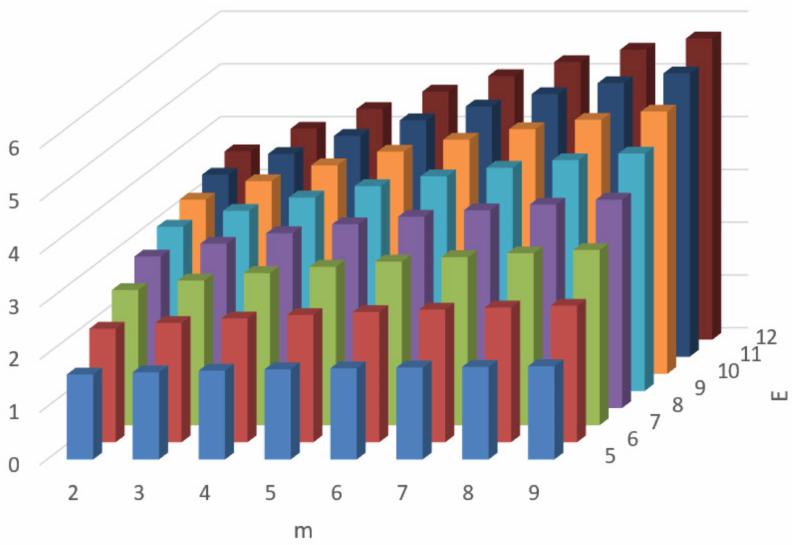
Figure 5. The values of the estimate (5) for a group of polynomials over GF ( 2 2 ) .